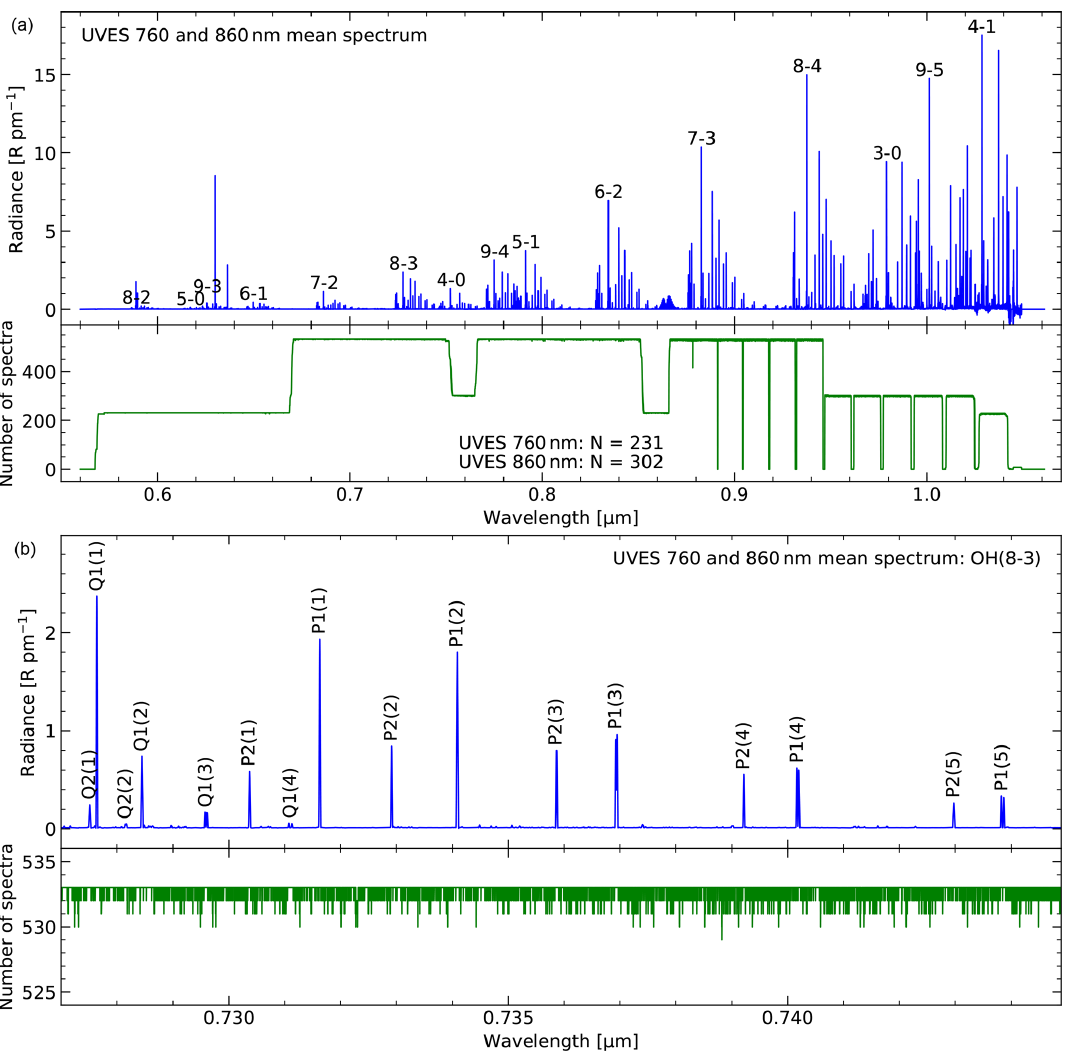
Figure 1. UVES mean spectrum in rayleighs per picometre. The full spectral range with labelled OH bands is shown in (a) . In (b) , a narrower wavelength range focusing on the Q and P branch of OH(8-3) is plotted. The lines are labelled. The wavelength-dependent number of spectra involved in the calculation of the mean spectrum is indicated in additional subpanels. This number varies due to the use of two set-ups centred on 760 and 860nm (with some variation) and the σ -clipping procedure for the mean calculation.